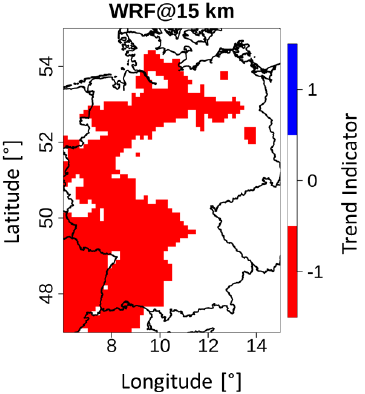
Figure 5. Grid-cell-based SPEI-3 trends for 1980–2009 based on the Mann–Kendall test for